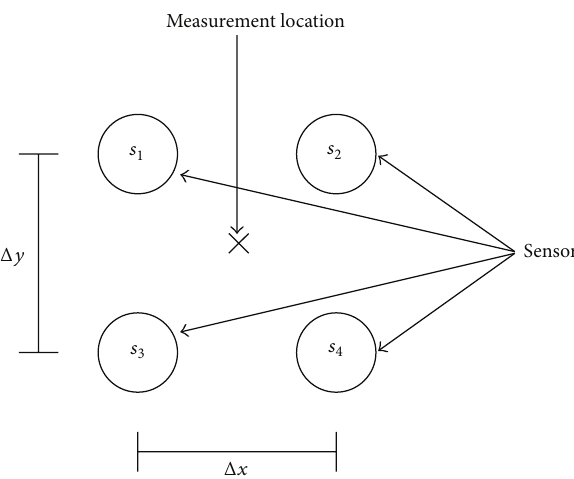
Figure 14: Schematic of accelerometer positions for WSSG mea- surement experimentally.